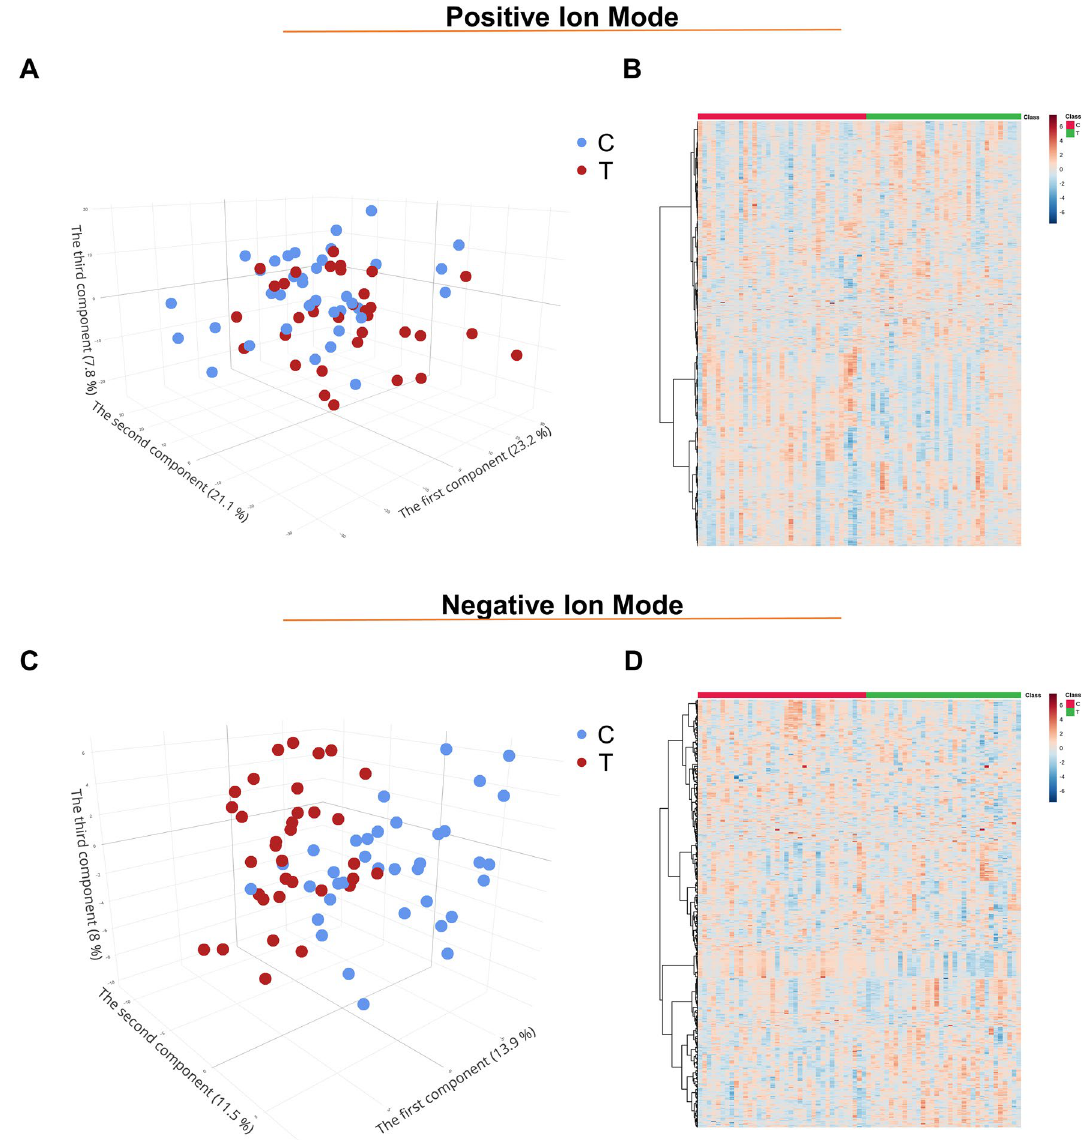
Figure 1. Plasma lipidome data visualization of Tuberculosis patients (N = 35) and Control (N = 37) group. ( a ) Principal components analysis 3D score plot of the two group in the positive ion mode. ( b ) Heatmap of all lipidome features between two group in the positive ion mode. ( c ) Principal components analysis 3D score plot of the two group in the negative ion mode. ( d ) Heatmap of all lipidome features between the two group in the negative ion mode. C control group, T Tuberculosis